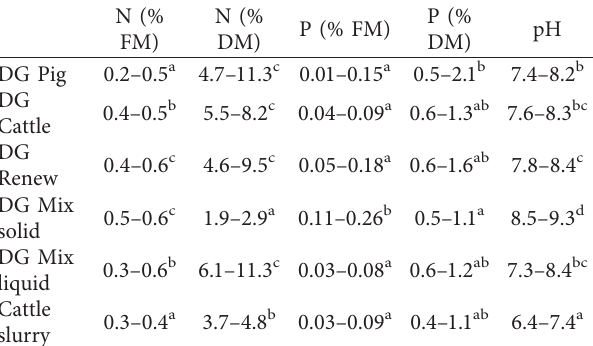
Table 2: Range of total N and P contents and pH of five digestates and cattle slurry (analyzed twice a year over six years; therefore, n � 12 (DG Mix liquid five years, n � 10), and different letters within columns mark significant differences between means (Scheff´e’s test, p ≤ 0 . 05)).